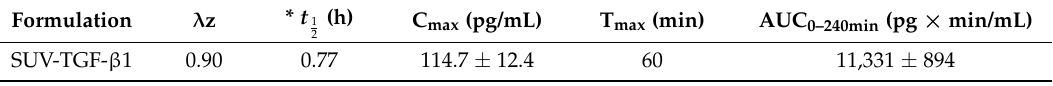
Table 2. Ocular tolerability of small unilamellar vesicles delivering TGF- β 1.